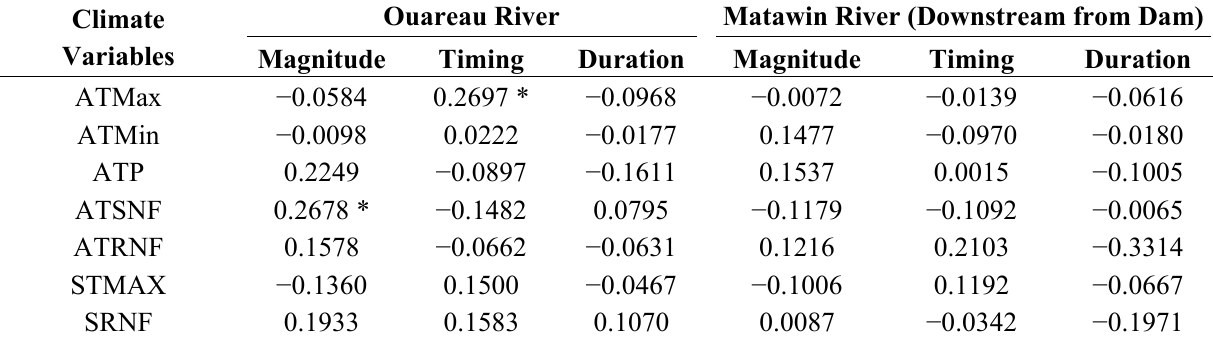
Table 7. Coefficients of correlation between characteristics of annual daily minimum flows and climate variables in regulated rivers